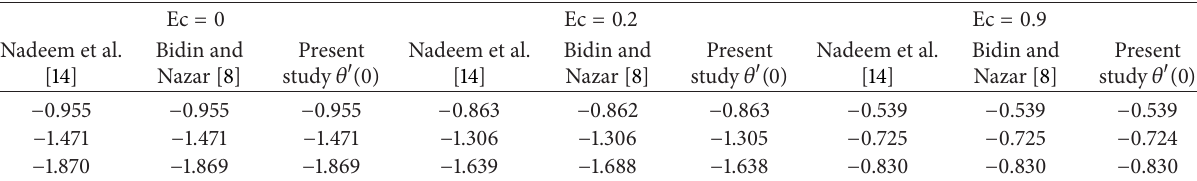
Table 1: Comparison of the results for the dimensionless wall temperature gradient 𝜃 󸀠 (0) (PEST case) by varying the Pr and Ec with 𝛽 = 𝑁 = 𝜆 = 𝑆 = 0 . Ec = 0 Ec = 0.2 Ec = 0.9 Pr